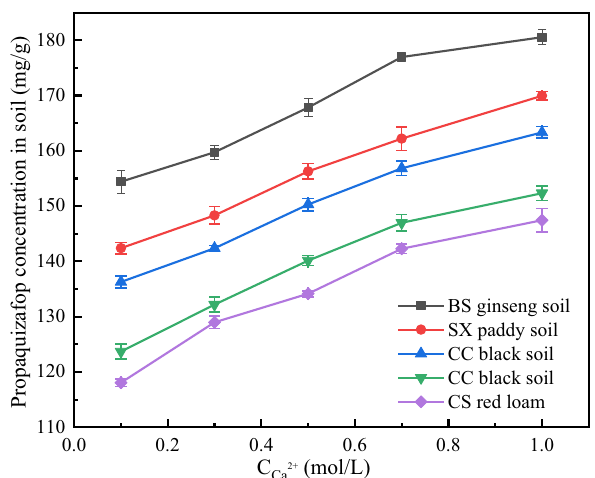
Figure 4. Effects of Ca 2+ on the adsorption of propaquizafop (n =